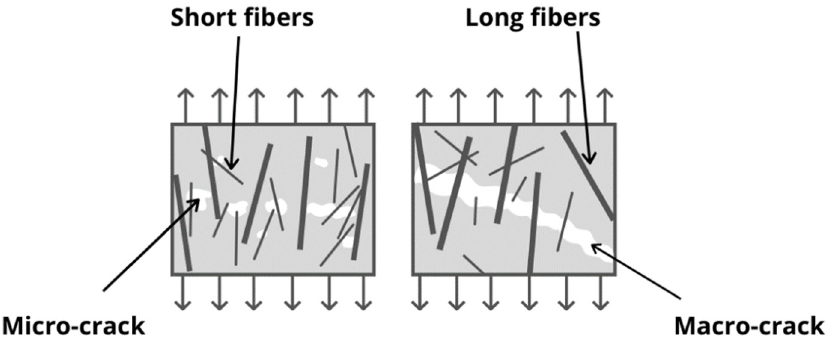
Figure 9. The blocking of crack propagation in fibre-reinforced concrete (based on literature 107).